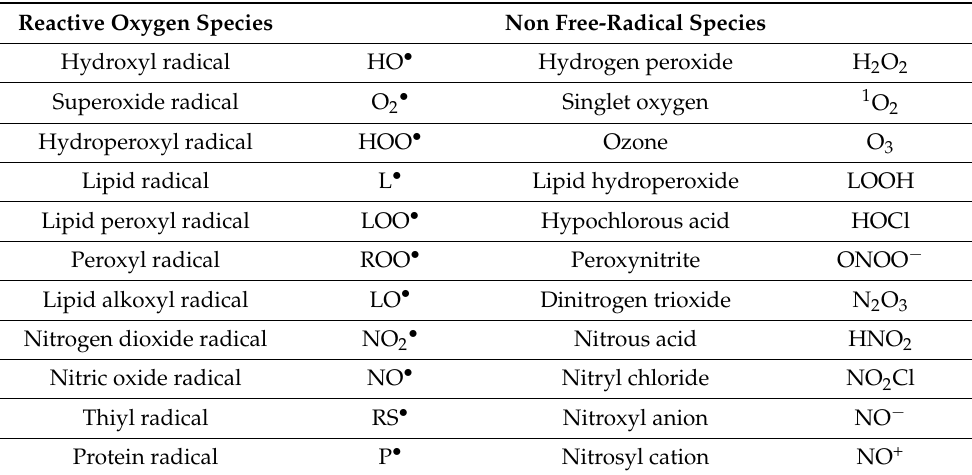
Table 1. Reactive oxygen species (ROS) and non free-radical